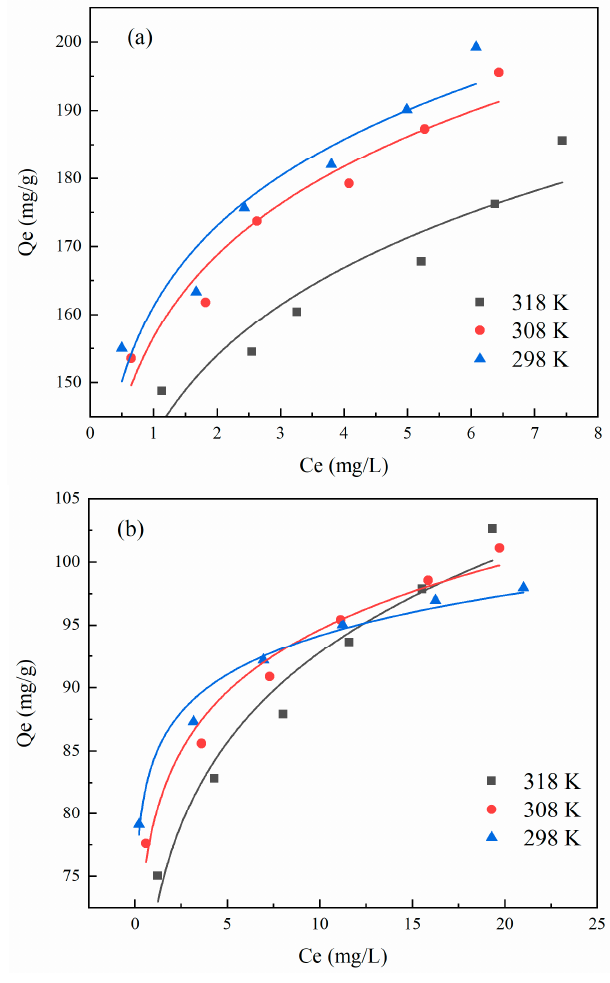
Figure 5. SAC adsorption isotherms for ( a ) MB and ( b ) OFL.